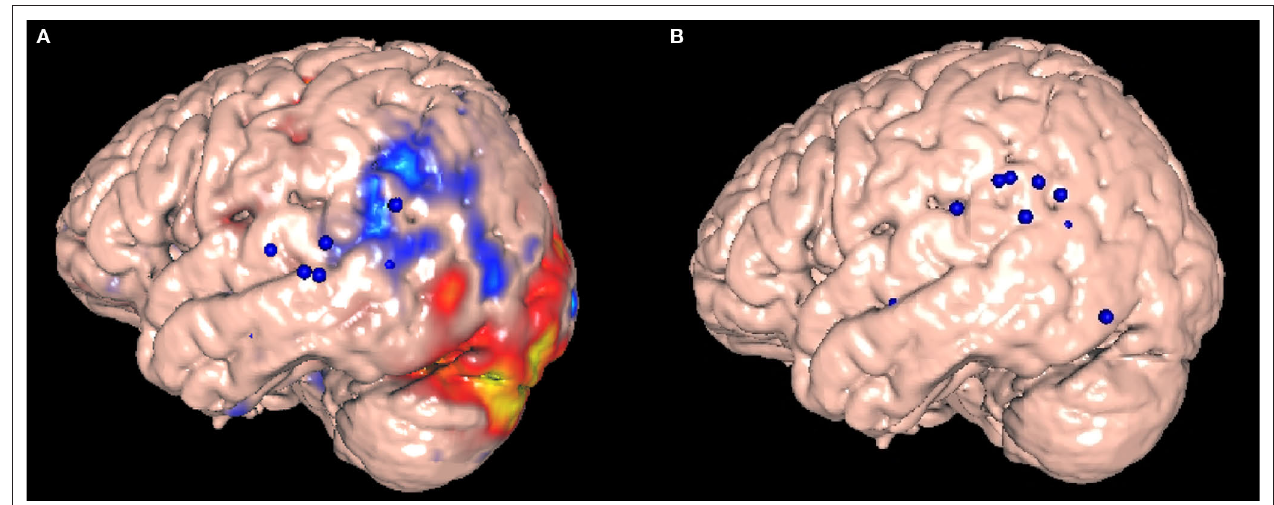
FIGURE 8 | 3-D Visualization of retrieved CSM sites mapped onto a canonical brain atlas. (A) Females, also showing a related fMRI study, (B)